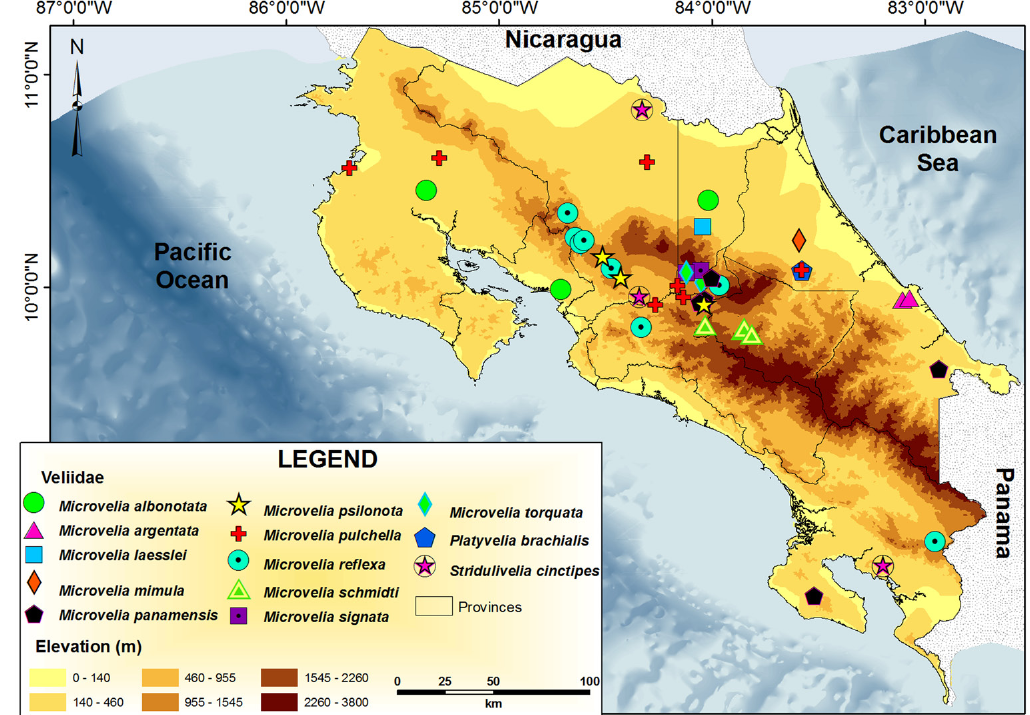
Figure 5 . Map of Costa Rica showing the collecting localities of the family